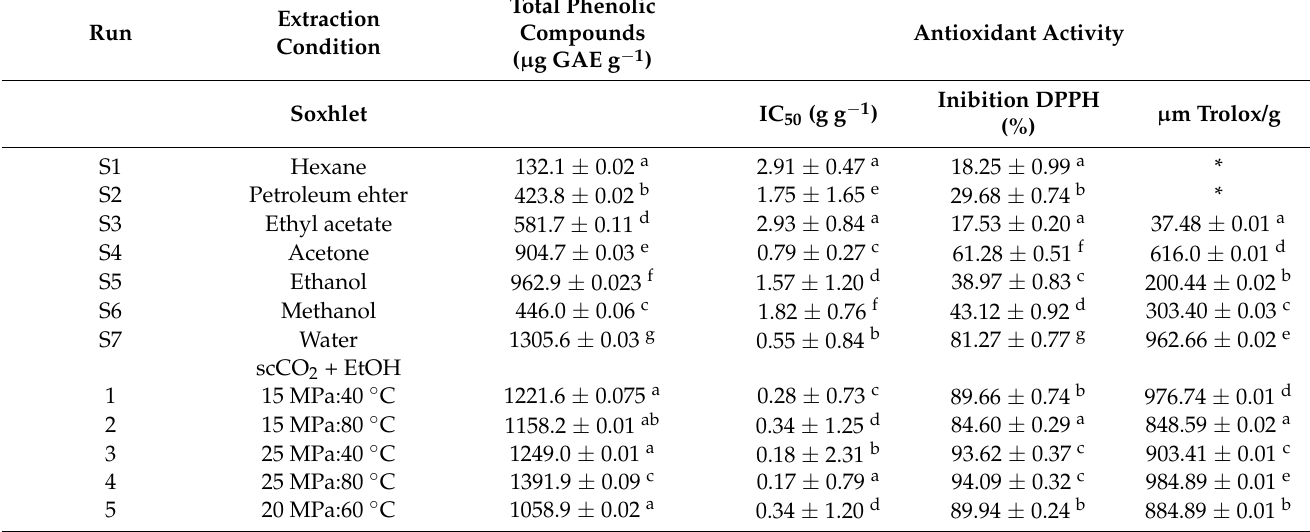
Table 4. Results of the phenolic compounds ( µ g GAE g − 1 ), with antioxidant activity expressed by the inhibitory concentration (IC 50 ), radical scavenging activity expressed by the DPPH (%), and the capacity equivalent to the radical Trolox ( µ m Trolox/g) of the Soxhlet and scCO 2 + EtOH